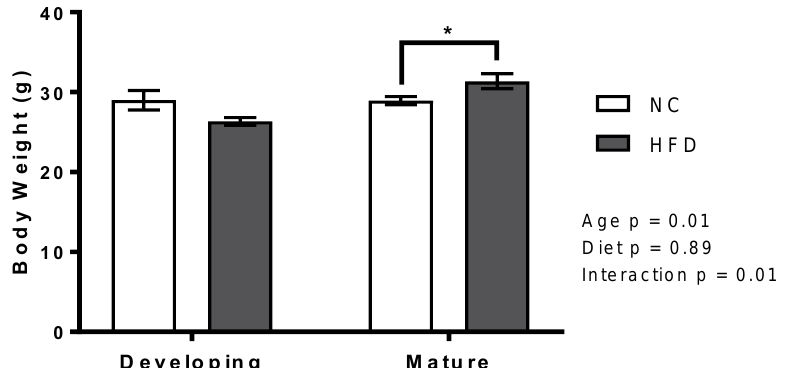
Figure 1. The high fat diet increased total body weight in the mature mice, but no change was seen between diets in the developing mice. Total body weight of the developing and mature mice after 10 weeks on normal chow (NC) and high fat diets (HFD) were measured by electronic scale. Results are presented as mean ± SEM ( n = 7 per group), * represents p < 0.05 (2-way ANOVA with unpaired t-test to compare diets within age groups).